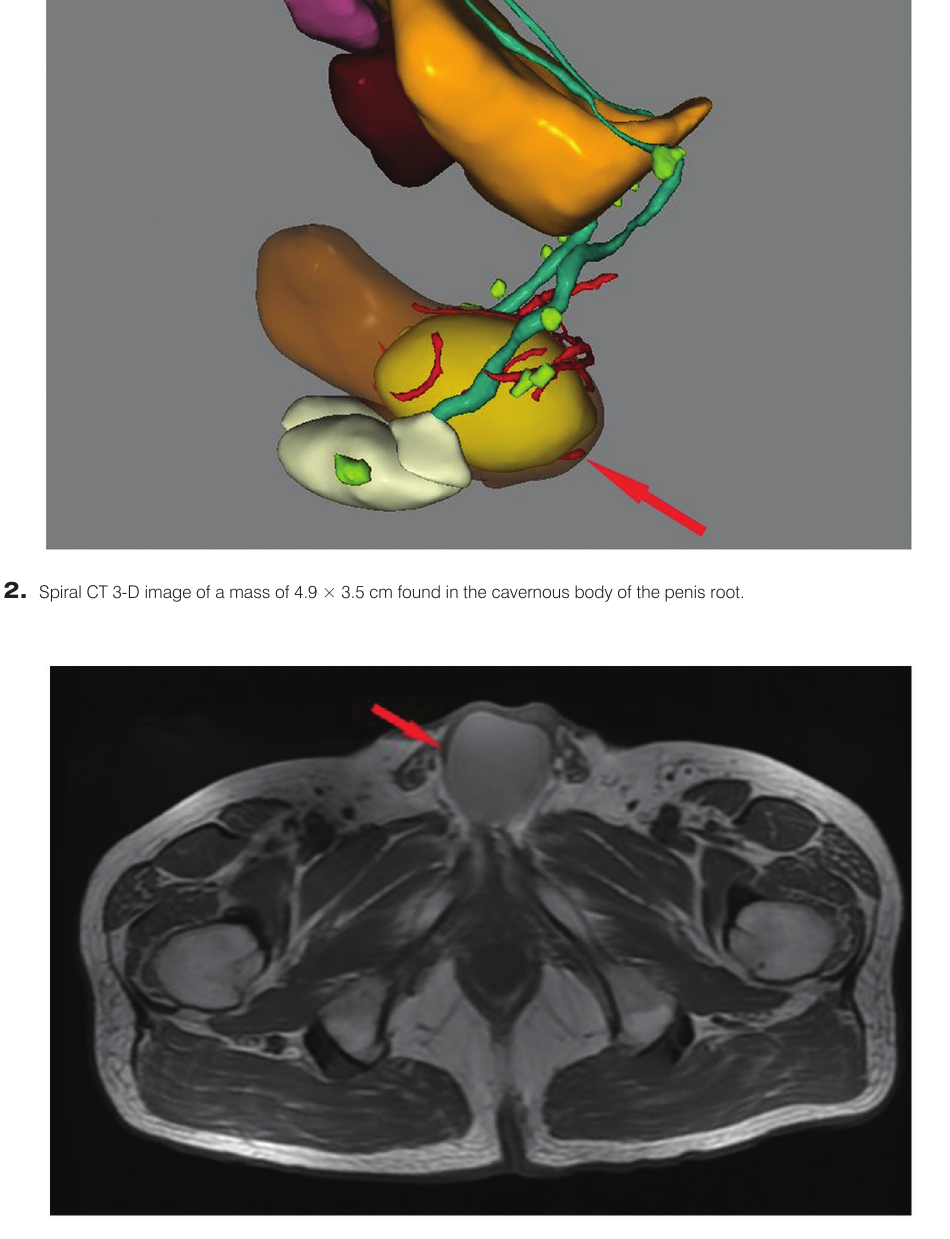
The patient recovered well after surgery and was discharged 1 week later. At 1.5 years after the operation, the shape of the penis returned to normal, and the erectile function was